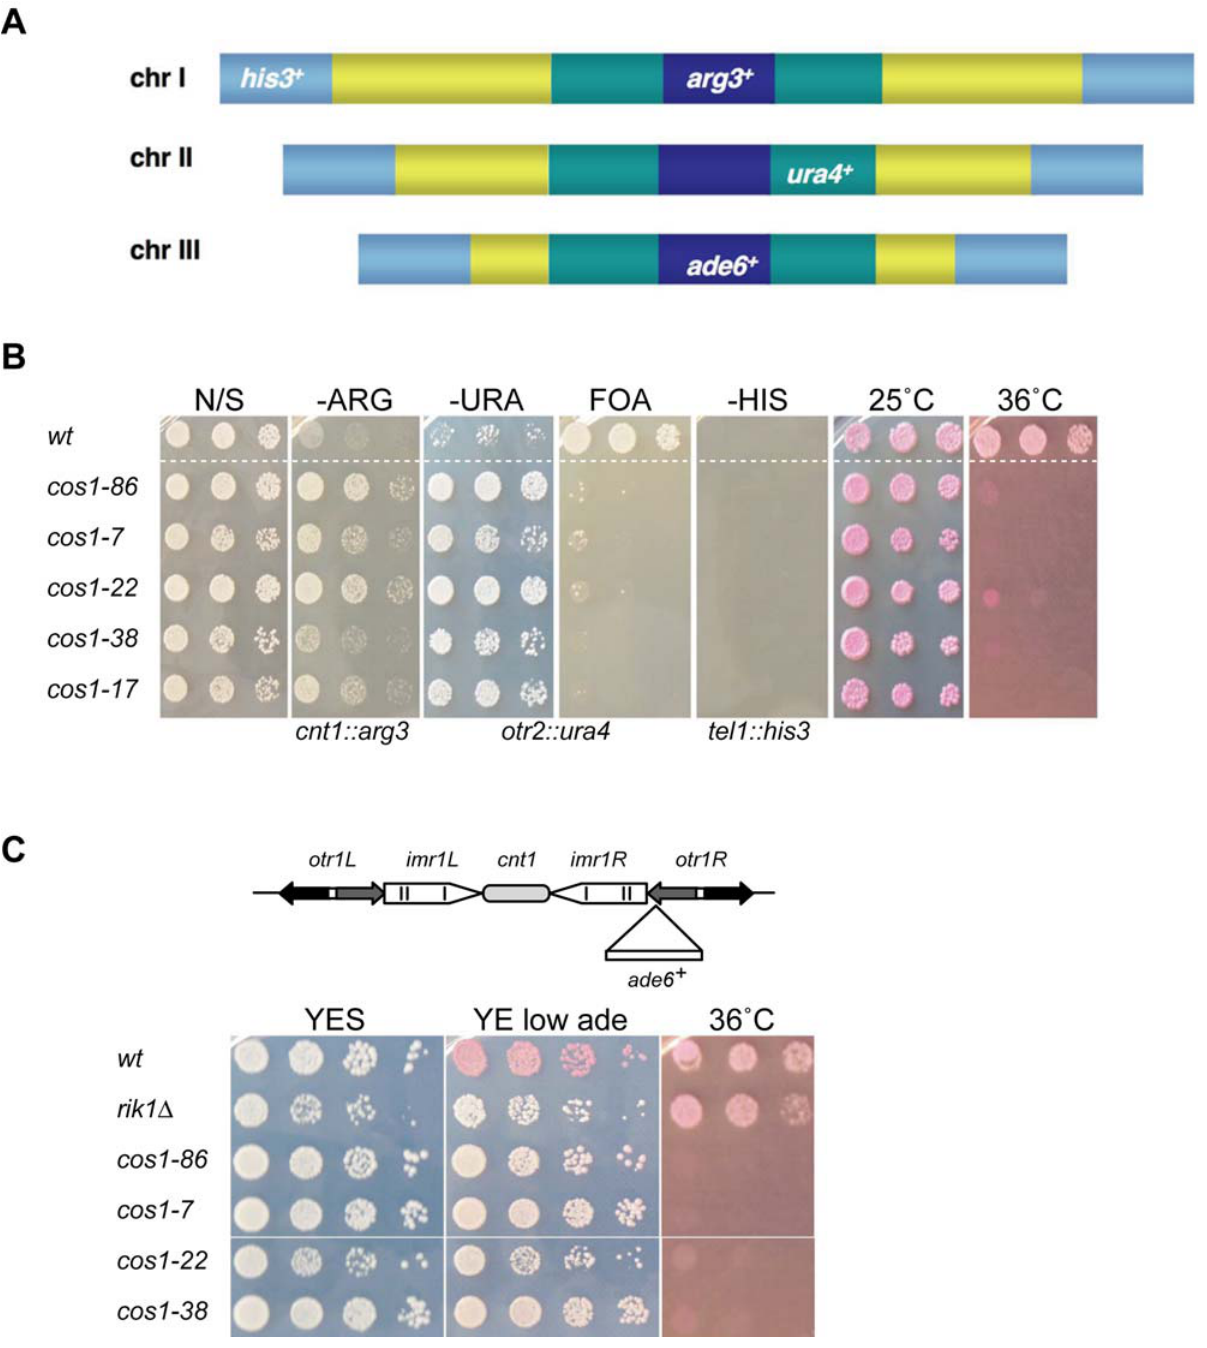
Figure 1. cos1 mutants alleviate central core and outer repeat silencing. ( A ) Schematic representation of FY3027 used to isolate mutants defective in central core and outer repeat silencing. FY3027 contains arg3 + at the central core of centromere 1 (dark blue) to monitor alleviation of central core silencing [ cnt1:arg3 + ], ura4 + at the outer repeat of centromere 2 (green) to monitor alleviation of outer repeat silencing [ otr2:ura4 + ], his3 + at telomere 1 (light blue) to monitor alleviation of silencing at telomeres [ tel1L:his3 + ] and ade6 + at the central core of cen3 [ cnt3:ade6 + ] [22]. Note that the ade6 + marker gene was not used for analysis. ( B ) Tenfold dilutions were plated onto non-selective (N/S) EMM or appropriate plates. cos1 mutant alleles alleviate silencing at the central core and outer repeats but do not affect silencing at the telomere. cos1 mutants are temperature sensitive for growth and fail to form colonies on Phloxin B at 36 u C. ( C ) cos1 mutants alleviate silencing of ade6 + gene inserted at otr1R . (upper panel) Schematic diagram of the ade6 + gene inserted at the outer repeats of centromere 1. (lower panel) Strains were plated on low adenine supplemented YES plates. In wild-type cells (FY1180), ade6 + is silenced and colonies are red in colour. cos1-86 , cos1-7 , cos1-22 and cos1-38 were found to partially alleviate silencing at the outer repeats and were pink in colour.